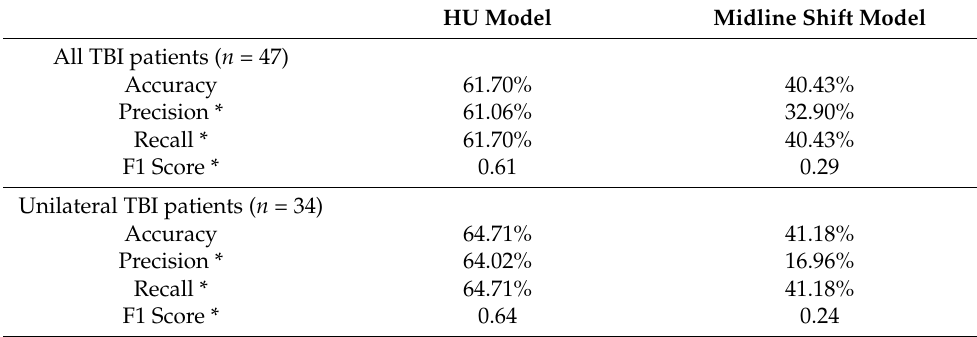
Table 4. Performance of models based on HU features and midline shift for the three classifications of